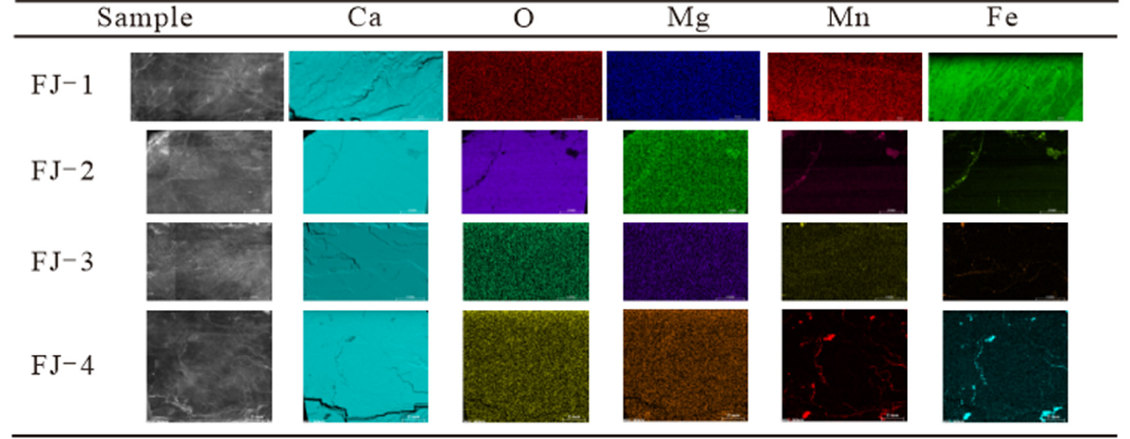
Figure 5. Morphologies and elements distribution of FJ-1, FJ-2, FJ-3, and FJ-4.